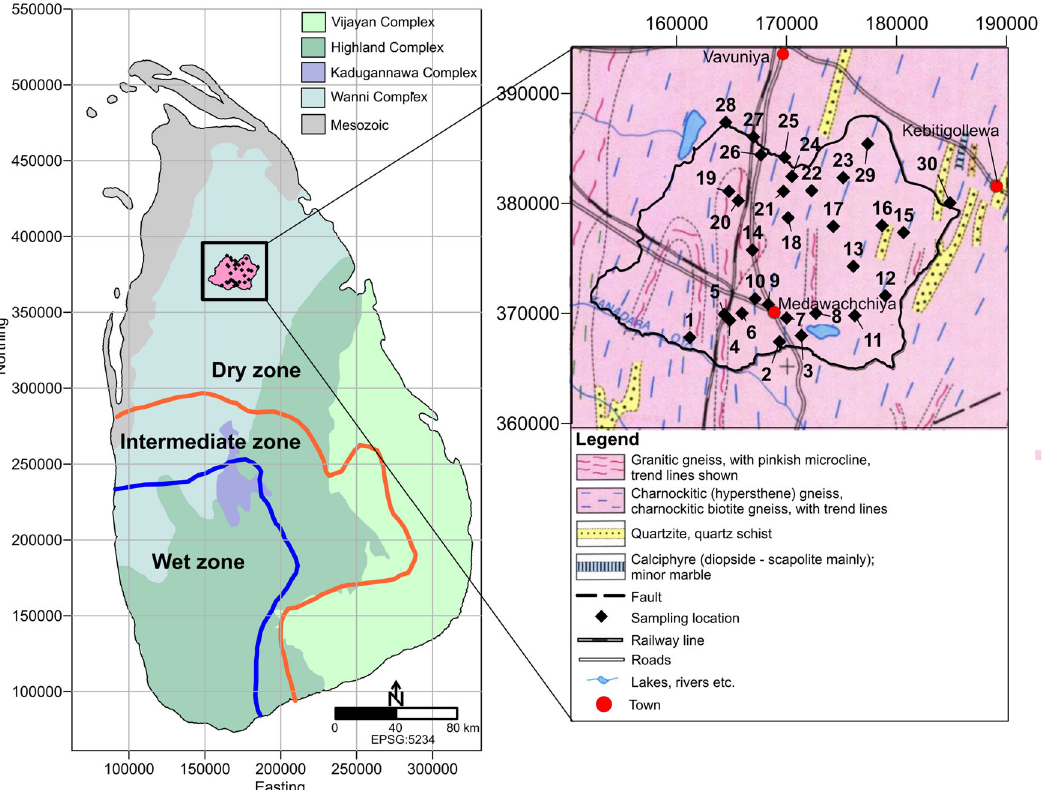
Fig. 5 Map of the study site. Geology of Sri Lanka showing the Precambrian lithotectonic units: Highland Complex, Wanni Complex, Vijayan Complex, and the Kadugannawa Complex (KC), and the Mesozoic unit to the north-west. Map adapted from Cooray 66 . Inset shows the sample locations (black diamonds) within the Medawachchiya district (black outline). The geology in the region is predominantly comprised of gneiss including charnockitic gneiss and biotite gneiss, with granitic gneiss, microcline, quartzite and quartz schist 67 . Samples 1 – 12 and 14 – 29 represent well water samples, while samples 13 and 30 represent spring water samples. Dry (<1750 mm year − 1 ), intermediate (1750 – 2500 mm year − 1 ) and wet (>2500 mm year − 1 ) zones are de fi ned by the blue and orange